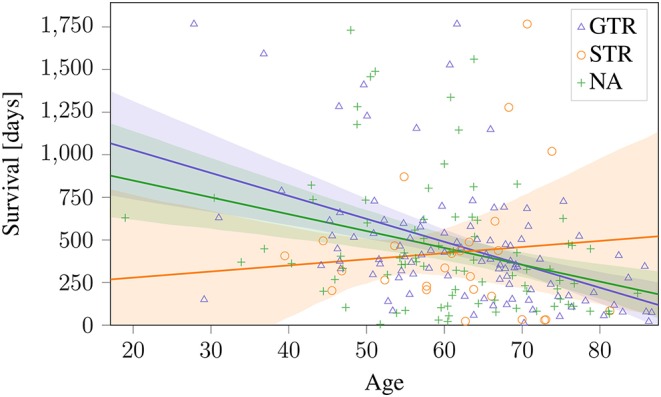
Age-only regression for the different types of resection status on BraTS 2019 training dataset. The obtained regression line is plotted together with the 95% confidence interval. This model is used as baseline against radiomics based approaches.